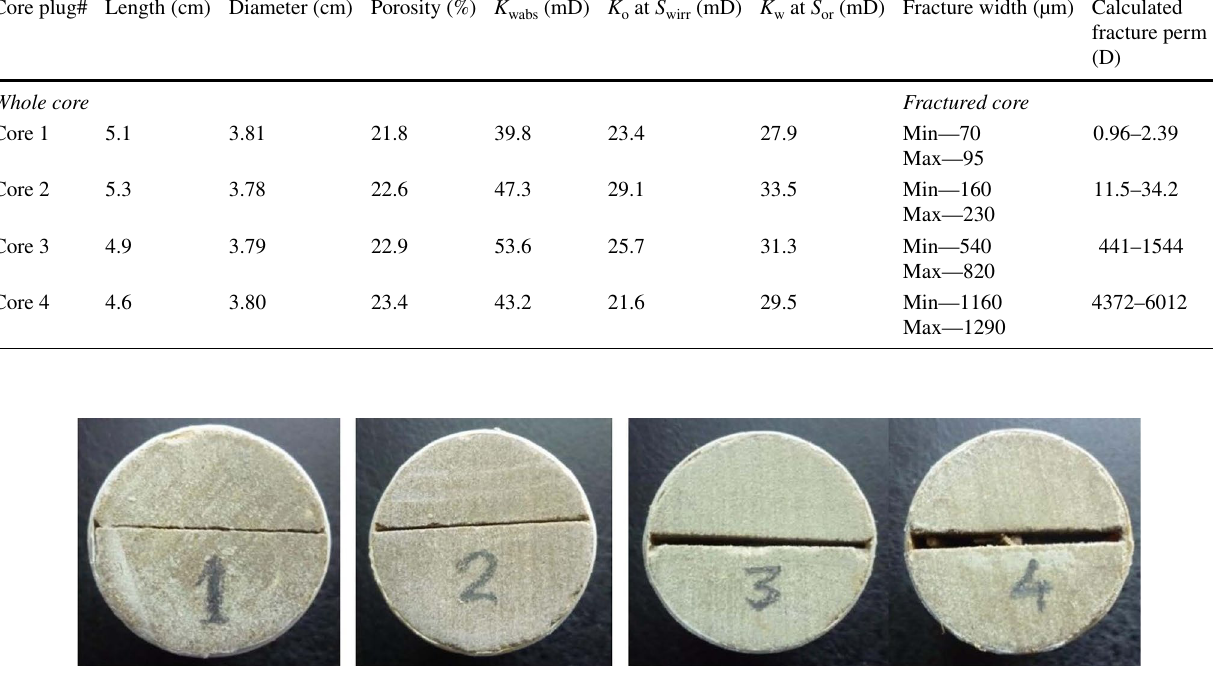
Table 2 Petrophysical properties of the test core plug